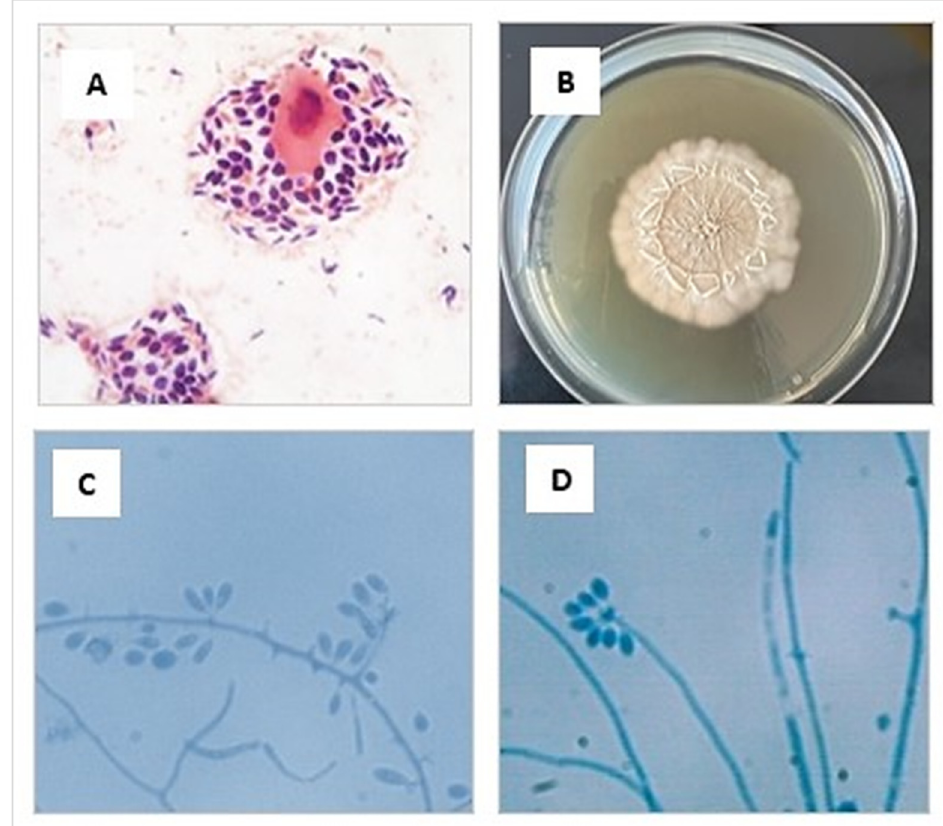
Figure 3. ( A ) Cytologic preparation collected from an ulcerated lesion of the cat’s skin showing an intermediate epithelial cell surrounded by many yeasts, stained using the Gram and observed at 1000× magnification. ( B ) Macromorphology of the colonies of S. brasiliensis cultivated in SGA medium for 10 days at 25 ◦ C ( C , D ) Preparation made from a microculture of a colony of S. brasiliensis grown in SGA. Septate hyaline hyphae are seen, and conidiogenous cells arise from undifferentiated hyphae, forming conidia in groups on small, clustered denticles, stained using the lactophenol cotton blue observed at 1000× magnification.